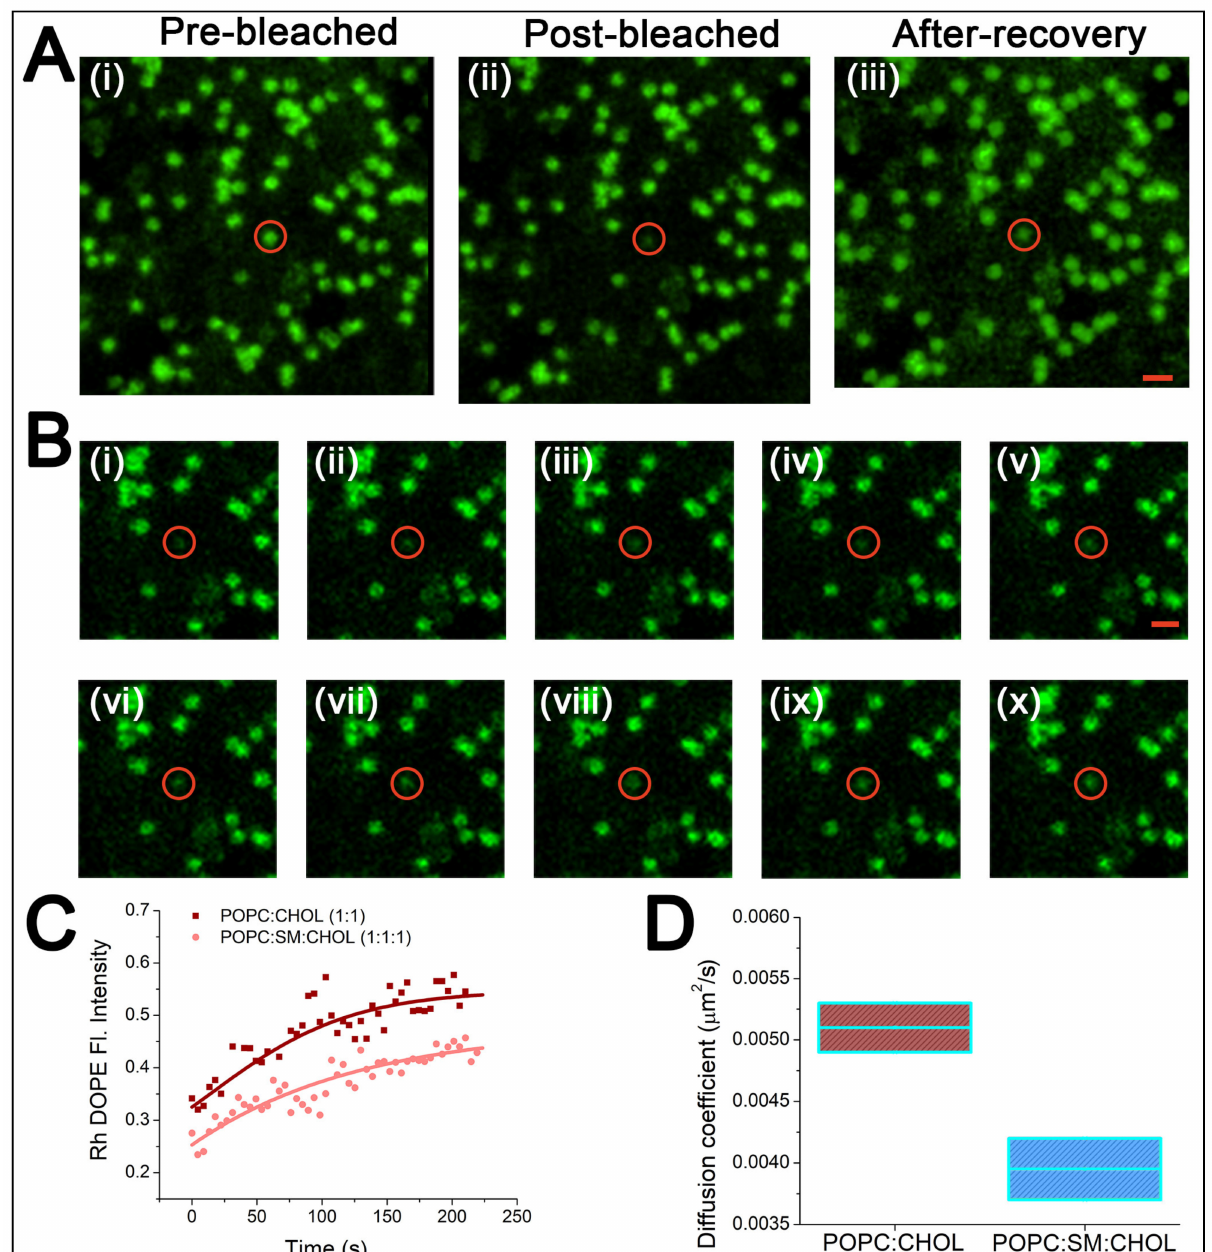
Figure 3. FRAP analysis of lipids in the SULB system. ( A ) Representative confocal microscopic images of RH-DOPE embedded in SULB systems composed of ternary lipid mixtures. ( i ) Prebleached, ( ii ) post-bleached and ( iii ) after recovery images are shown for the ternary SULB system. The red circle denotes the selected spot for bleaching. Scale bar = 2 µ m. ( B ) Time lapse image sequences ( i – ix